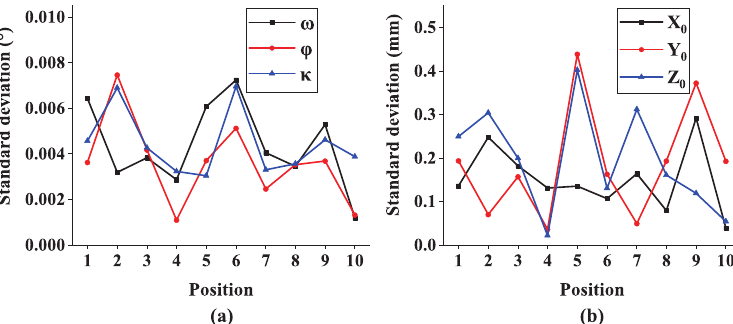
Figure 15. 6-DOF measurement repeatability: ( a ) standard deviations of rotations and ( b ) standard deviations of positions.